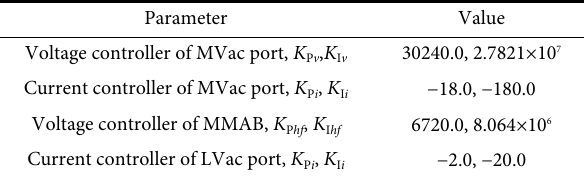
Table 4 Control parameters of the four-port PET